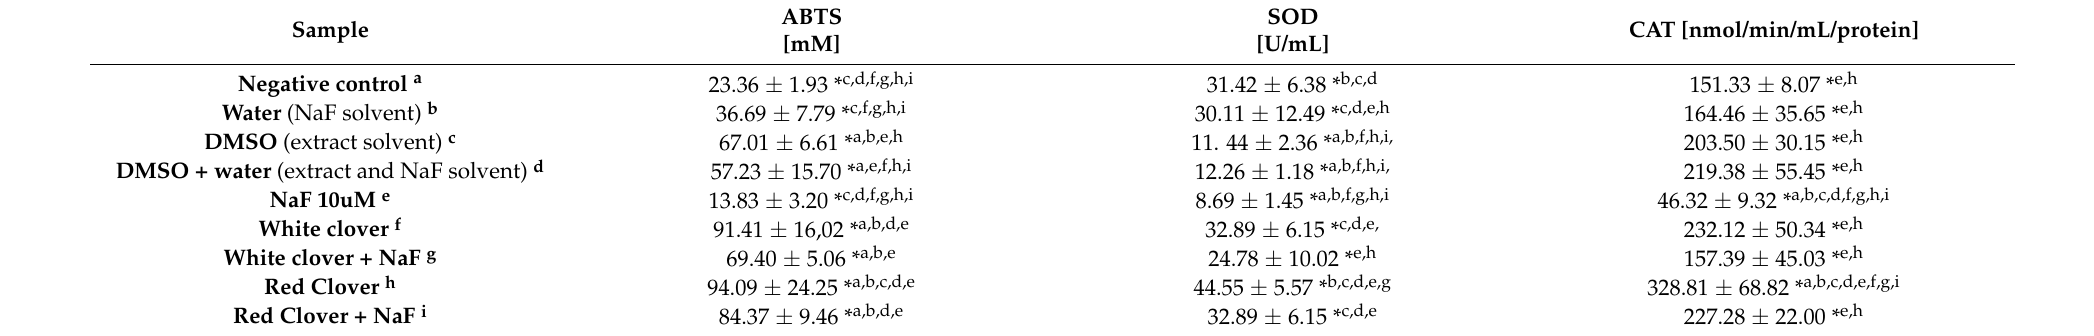
Table 3. Antioxidant potential in cell cultures THP-1 with clover flower extracts (ABTS, enzyme activity—SOD, CAT). Different letters (a–i) in the columns represent statistically significant differences—* FDR p < 0.05 between particular subgroup, n = 5